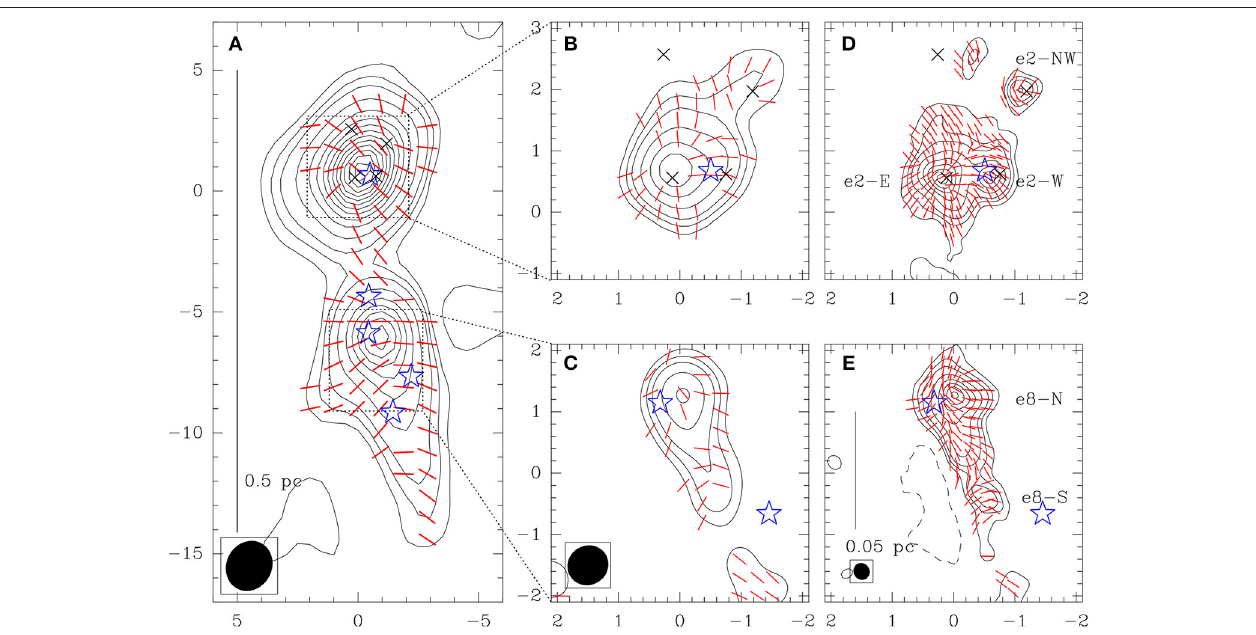
FIGURE 6 | Magnetic fields (red line segments) in W51 e2 and e8 obtained from the SMA and ALMA that exhibit more substructure at higher angular resolution. (A) SMA observations at 870 µ m probing large scales at a resolution of 2 ′′ ( 10,000au). (B,C) SMA observations with a resolution of 0. ′′ 7 ( 3,500au) at 870 µ m. ∼ ∼ (D,E) ALMA observations at 1.3mm with a resolution of 0. ′′ 26 ( 1,330au). Contours are Stokes I dust continuum intensity at levels of 3,6,10,20,35,50,65,80,95... ∼ times 75mJybeam − 1 in (A) , 60mJybeam − 1 in (B,C) , and 6mJybeam − 1 in (D,E) . symbols in (A,B,D) mark the known continuum sources W51 e2-E, e2-W, × e2-NW, and e2-N. Star symbols indicate known ultra-compact H II ( UCH II ) regions. Synthesized beams are shown as ellipses at the lower-left corner of (A,C,E) . Adapted from Koch et al. (2018). Reproduced with permission from the